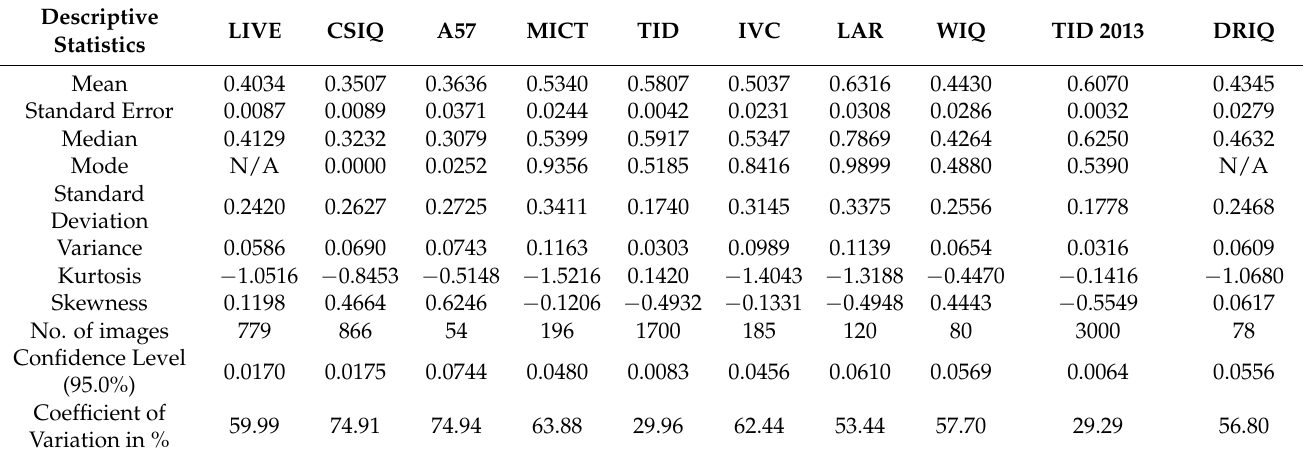
Table 3. Summary of descriptive statistical analysis over ten benchmark